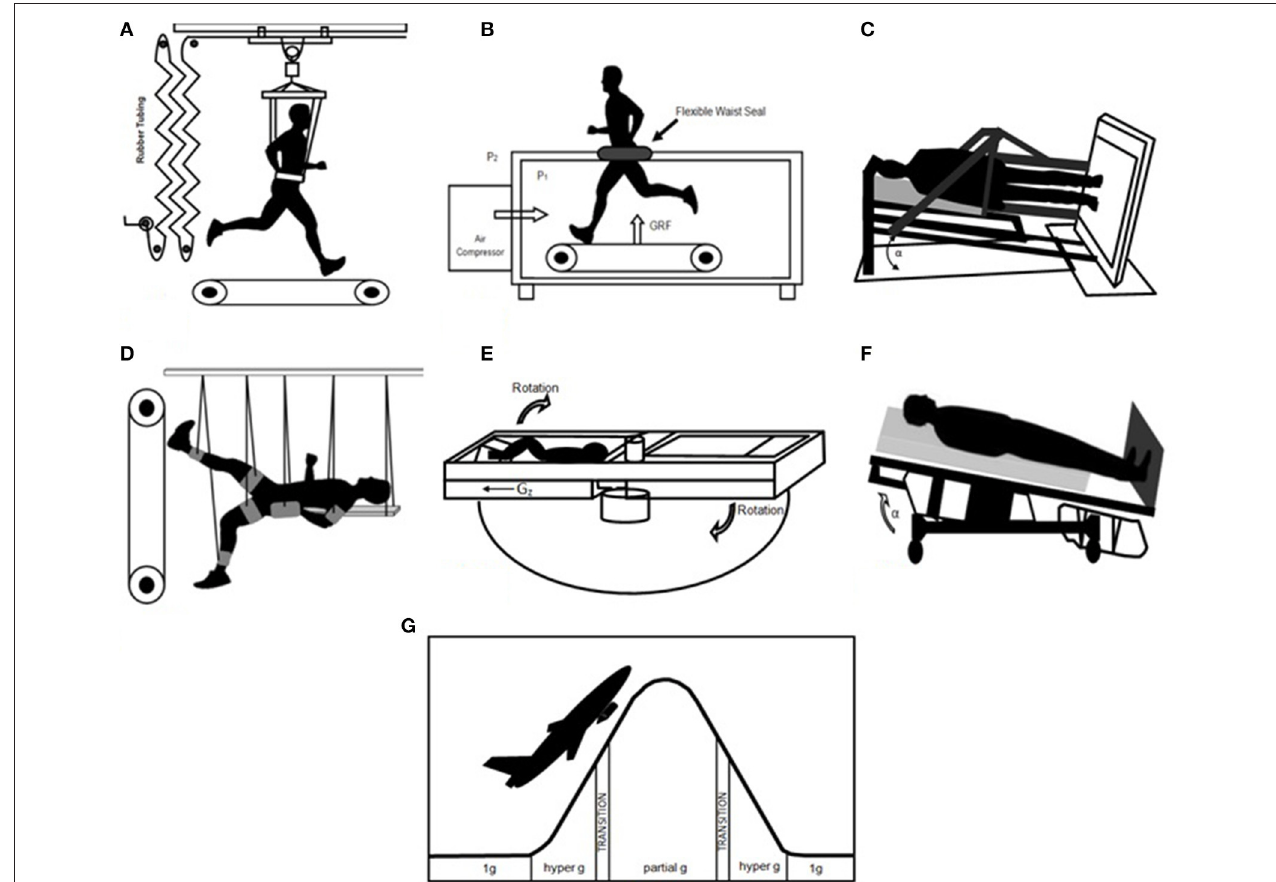
FIGURE 1 | Partial gravity simulation models. (A) Vertical body weight support system (modified from Kram et al., 1997) (B) Lower body positive pressure treadmill (modified from Cutuk et al., 2006) (C) Tilted body weight support system (modified from Sylos-Labini et al., 2013) (D) Supine suspension system (modified from De Witt et al., 2008) (E) Centrifugation (modified from Katayama et al., 2004) (F) Head-up tilt (modified from Cavanagh et al., 2013) (G) Partial gravity parabolic flight (according to ESA 1st Joint European Partial Gravity Parabolic Flight Campaign,